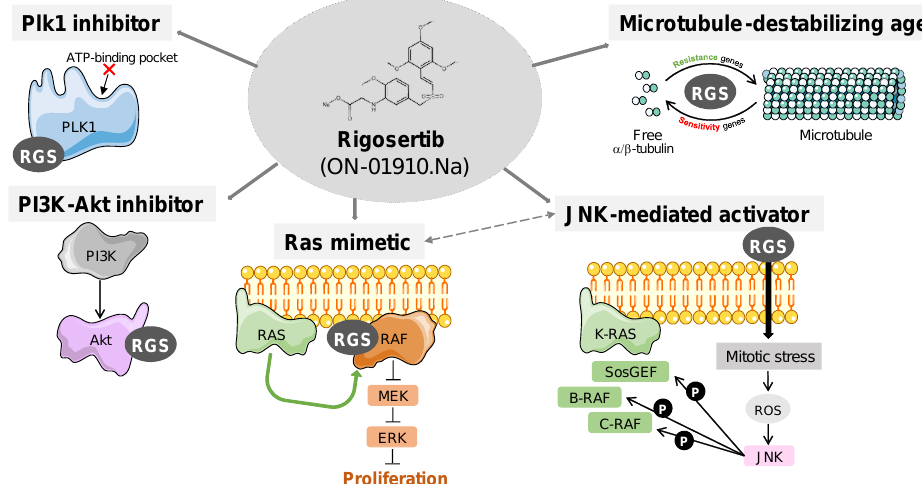
Figure 2. Diagram showing the described rigosertib targets and mechanisms of action. Rigosertib was first described as an allosteric Plk1 inhibitor [1]. Other data show that rigosertib can inhibit the PI3K–Akt signaling axis [2,3]. Rigosertib is also defined as a Ras–Raf binding competitor, altering the Ras–MAPK signaling cascade [4]. This Ras–Raf signaling impairment might be due to altering the response of stress kinases such as JNK [6]. Finally, using CRISPR genome-wide screens, rigosertib is also identified as a microtubule destabilizing agent [5].